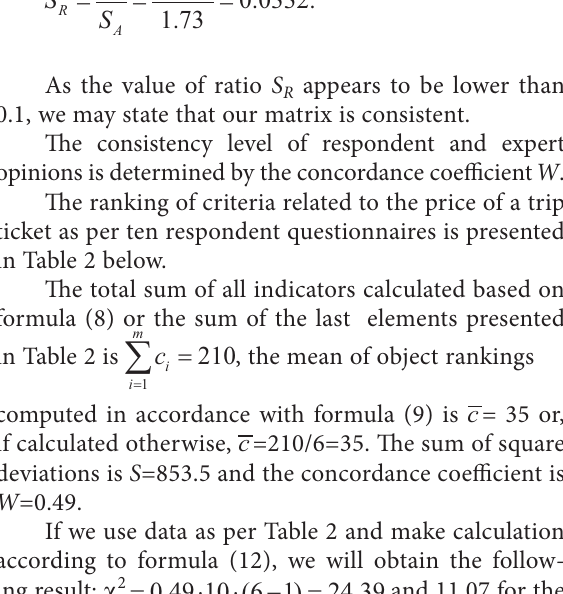
Table 2. Ranking ticket price-related criteria as per respondent questionnaires Criteria